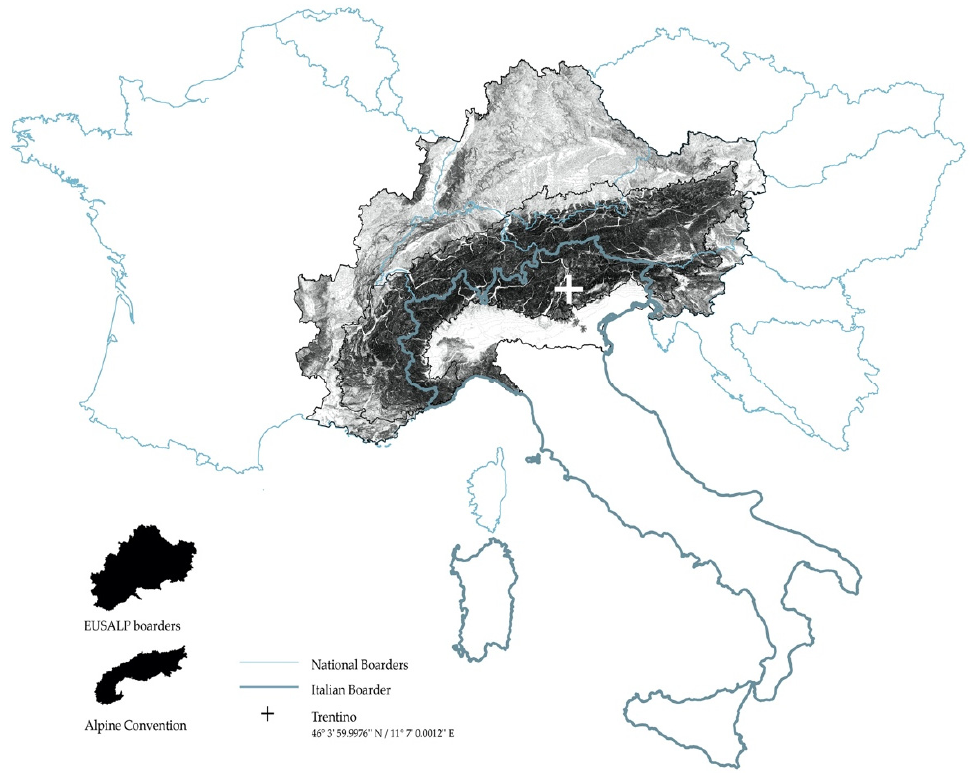
Figure 1. The map shows the location of Trentino within the Alpine region (in comparison with the EUSALP and Alpine Convention boundaries). Trentino is a predominantly mountainous province with a complex geomorphology. More than 70% of the entire territory lies 1000 m above sea level between the southern Rhaetian Alps and the Dolomites (highest peak of Cevedale: 3769 m). The morphology is characterized by a close network of valleys and a tangle of variously oriented and branching ridges, with flat strips of fluvioglacial excavation of the valley floors (source: “Europe” Geofabrick Download Server, graphic elaboration by the authors,